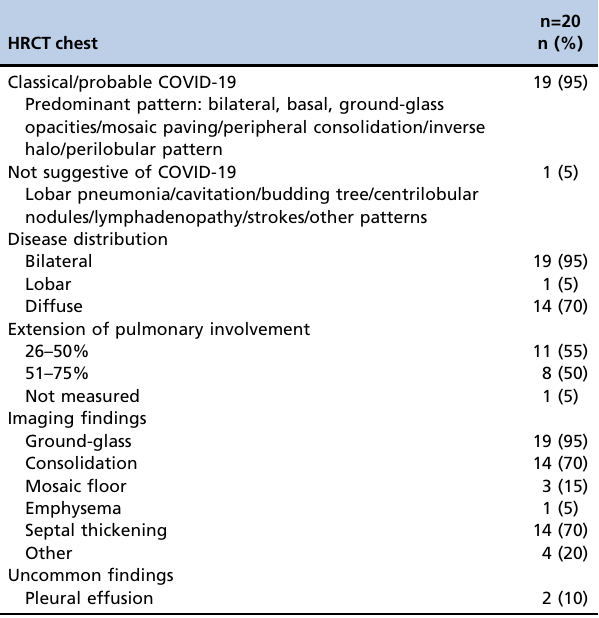
HRCT: High-resolution computed tomography.